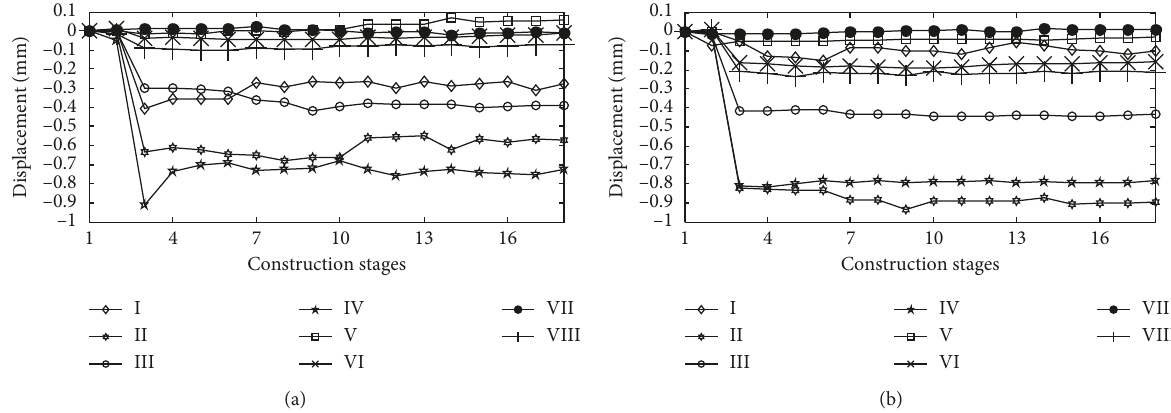
Figure 14: Relative horizontal displacement of adjacent buildings: (a) relative horizontal displacement of the left building; (b) relative horizontal displacement of the right